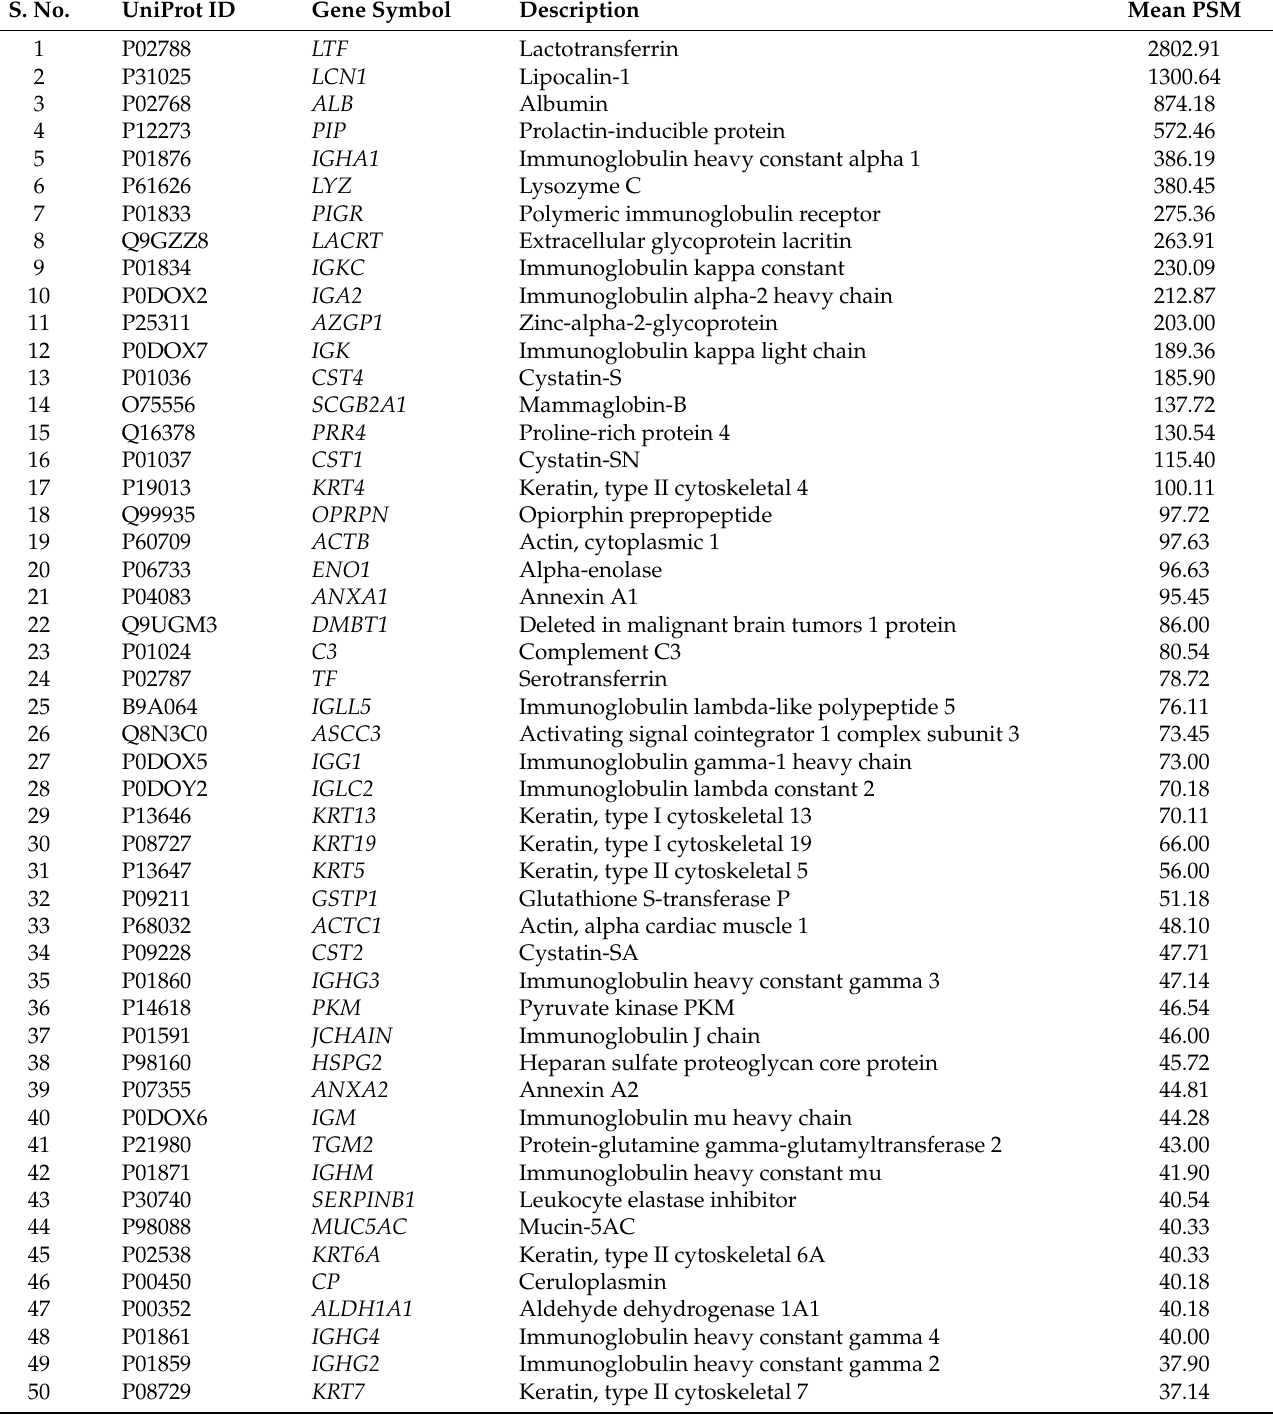
Table 3. Top 50 proteins identified in tear samples using in-strip protein digestion and HCD fragmen-